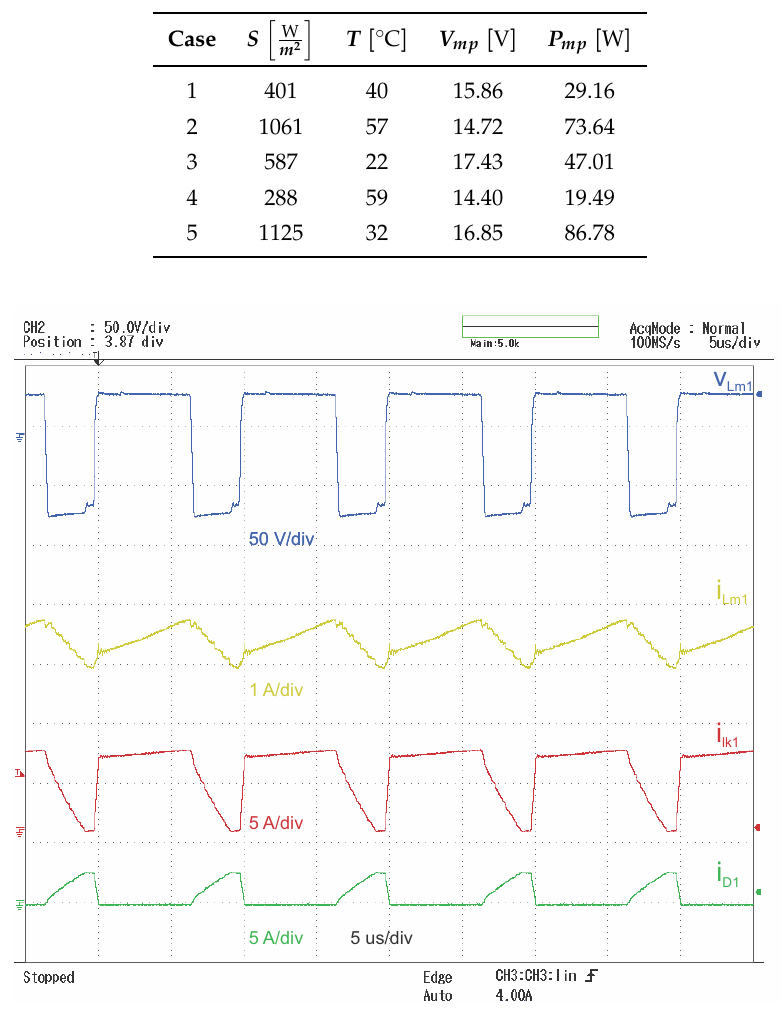
Figure 8. Main experimental waveforms of the